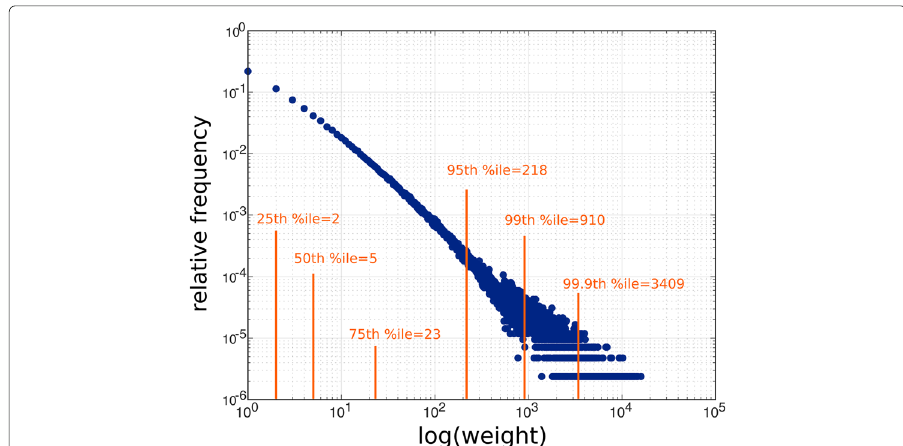
Fig. 3 Distribution of link weights. The distribution of link weights. According to the method devised in Ref. Clauset et al. (2009), the null hypothesis that the weights have a power-law distribution is